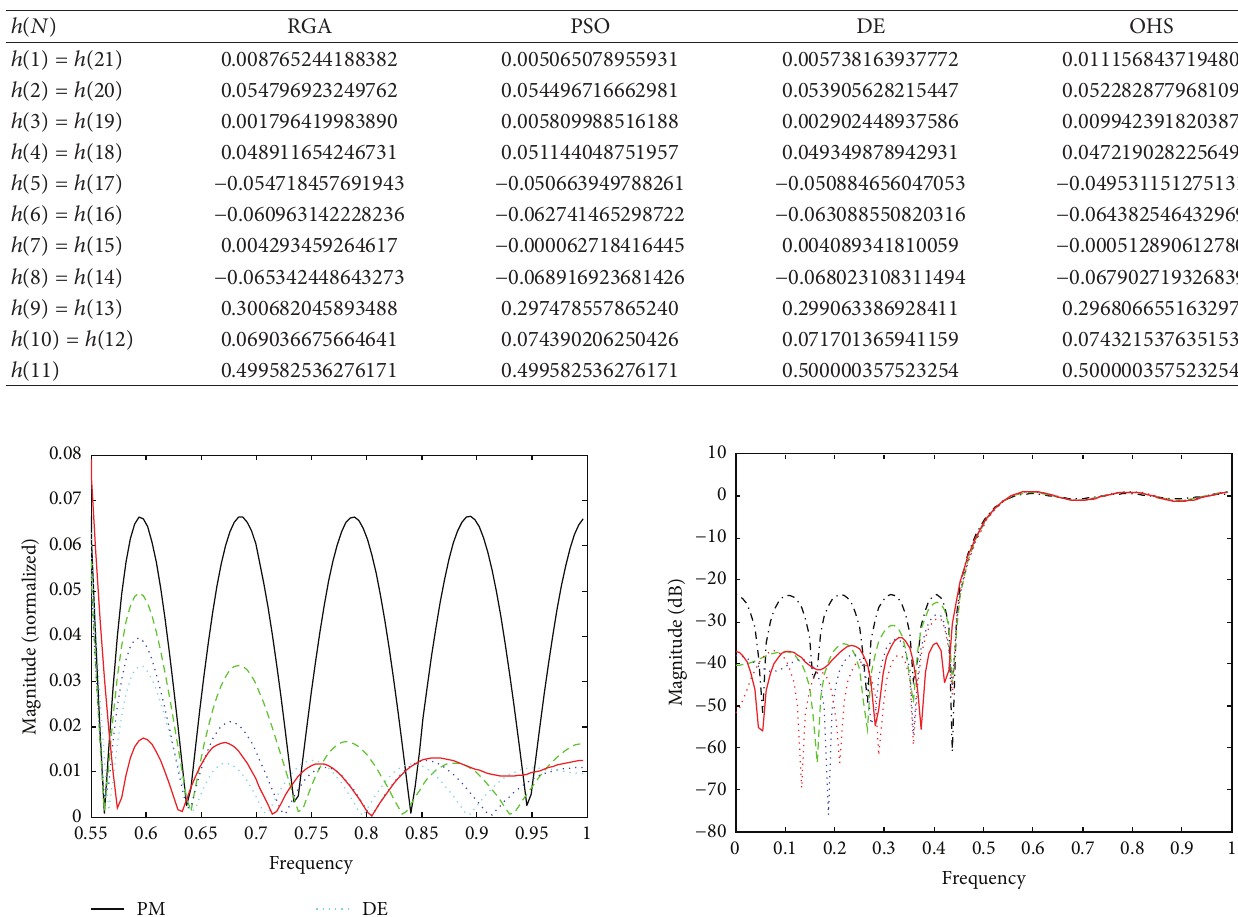
Table 5: Optimized coefficients of the FIR BS filter of order 20.